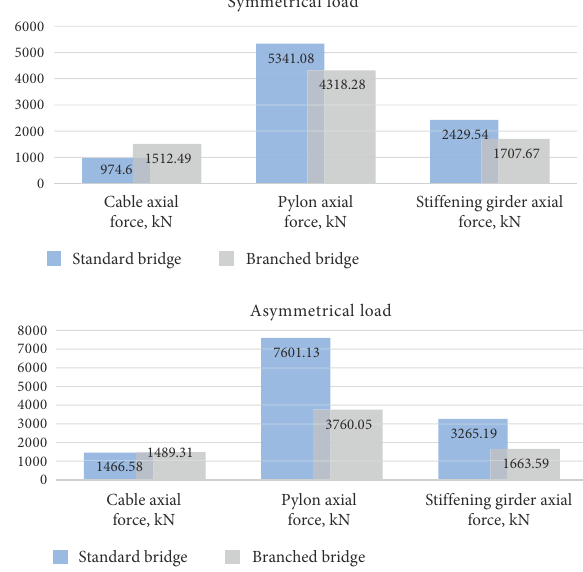
Figure 11. The results of the comparative analysis of the axial forces. The blue colour indicates the standard bridge data, the grey colour – the branched bridge